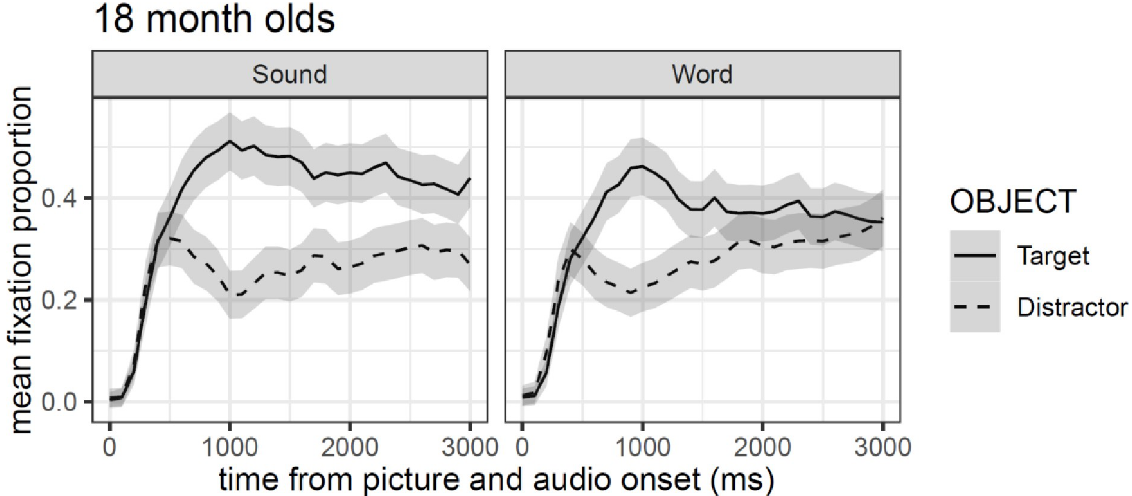
Fig 9. Mean fixation proportion (aggregated by participants) as a function of object in the visual context and type of auditory stimulus. Shaded areas around lines represented 95% confidence intervals adjusted for within-subject designs and multiple time windows.